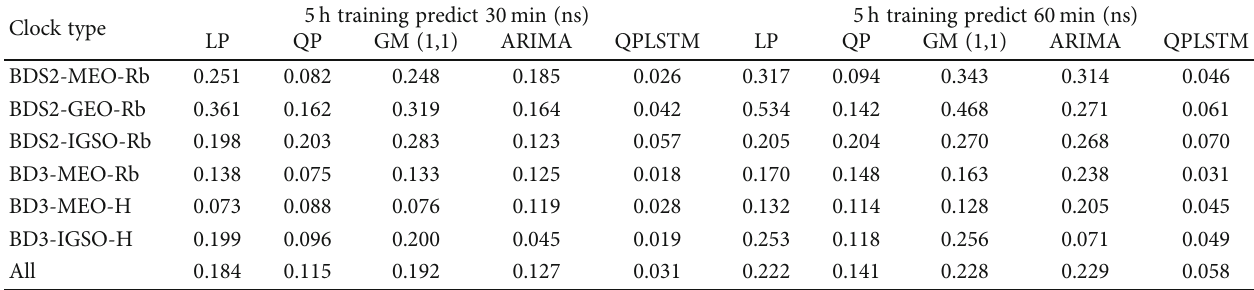
Table 6: 30min and 60 min average prediction MAE for six di ff erent clock categories based on the fi ve models for 24 h. Clock